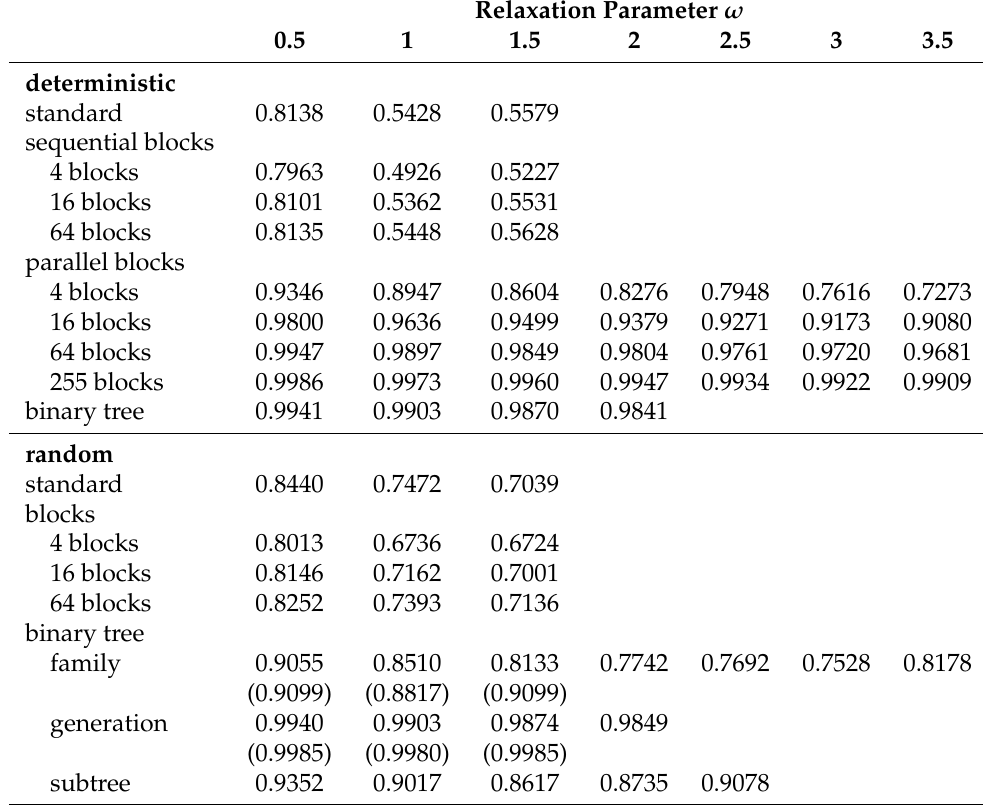
Table 1. Convergence factors for various algorithms, for a random underdetermined equation of size 255 × 1023. Numbers in parentheses represent the estimates from Equation